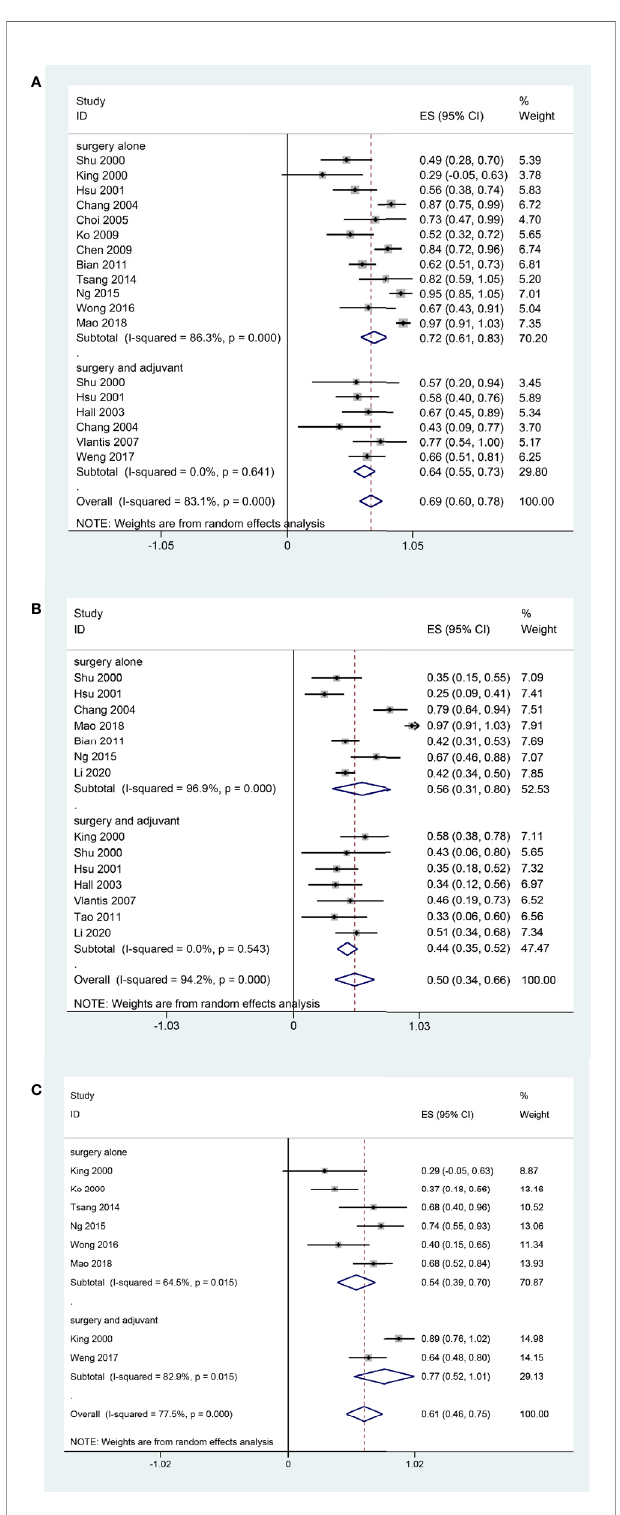
FIGURE 3 | Forest plot of subgroup meta-analysis Pooled 2-year OS (A) ; Pooled 5-year OS (B) ; Pooled 2-year DFS (C) . Subgroups were strati fi ed according to the postoperative adjuvant therapy status of the patients in each study.